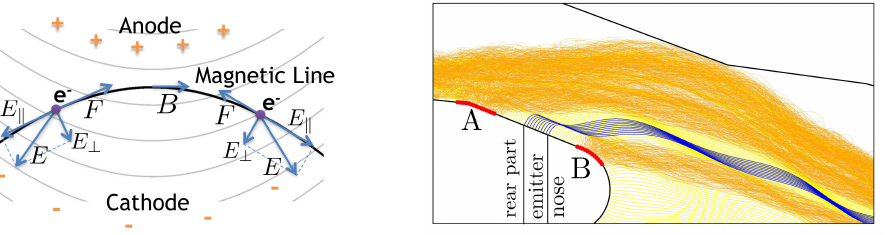
Figure 1. Equipotential lines are intersected by a magnetic field line formulating a magnetic potential well (left). Secondary electrons emitted from the region A and B are adiabatically trapped and they contribute to the generation of the harmful beam halo (right).